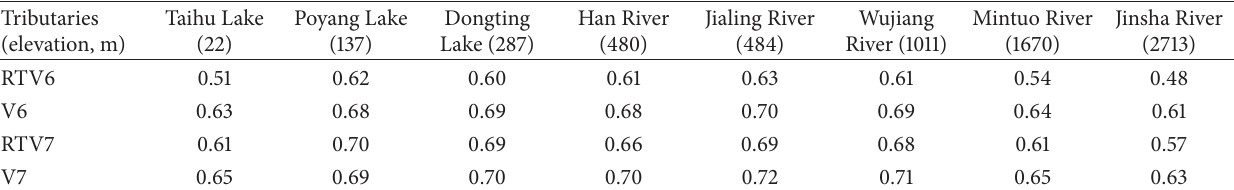
Figure 5: The same as Figure 4, but for the average monthly mean precipitation. Table 2: The correlation coefficient between the TMPA products and observed precipitation of 8 tributaries of the Yangtze